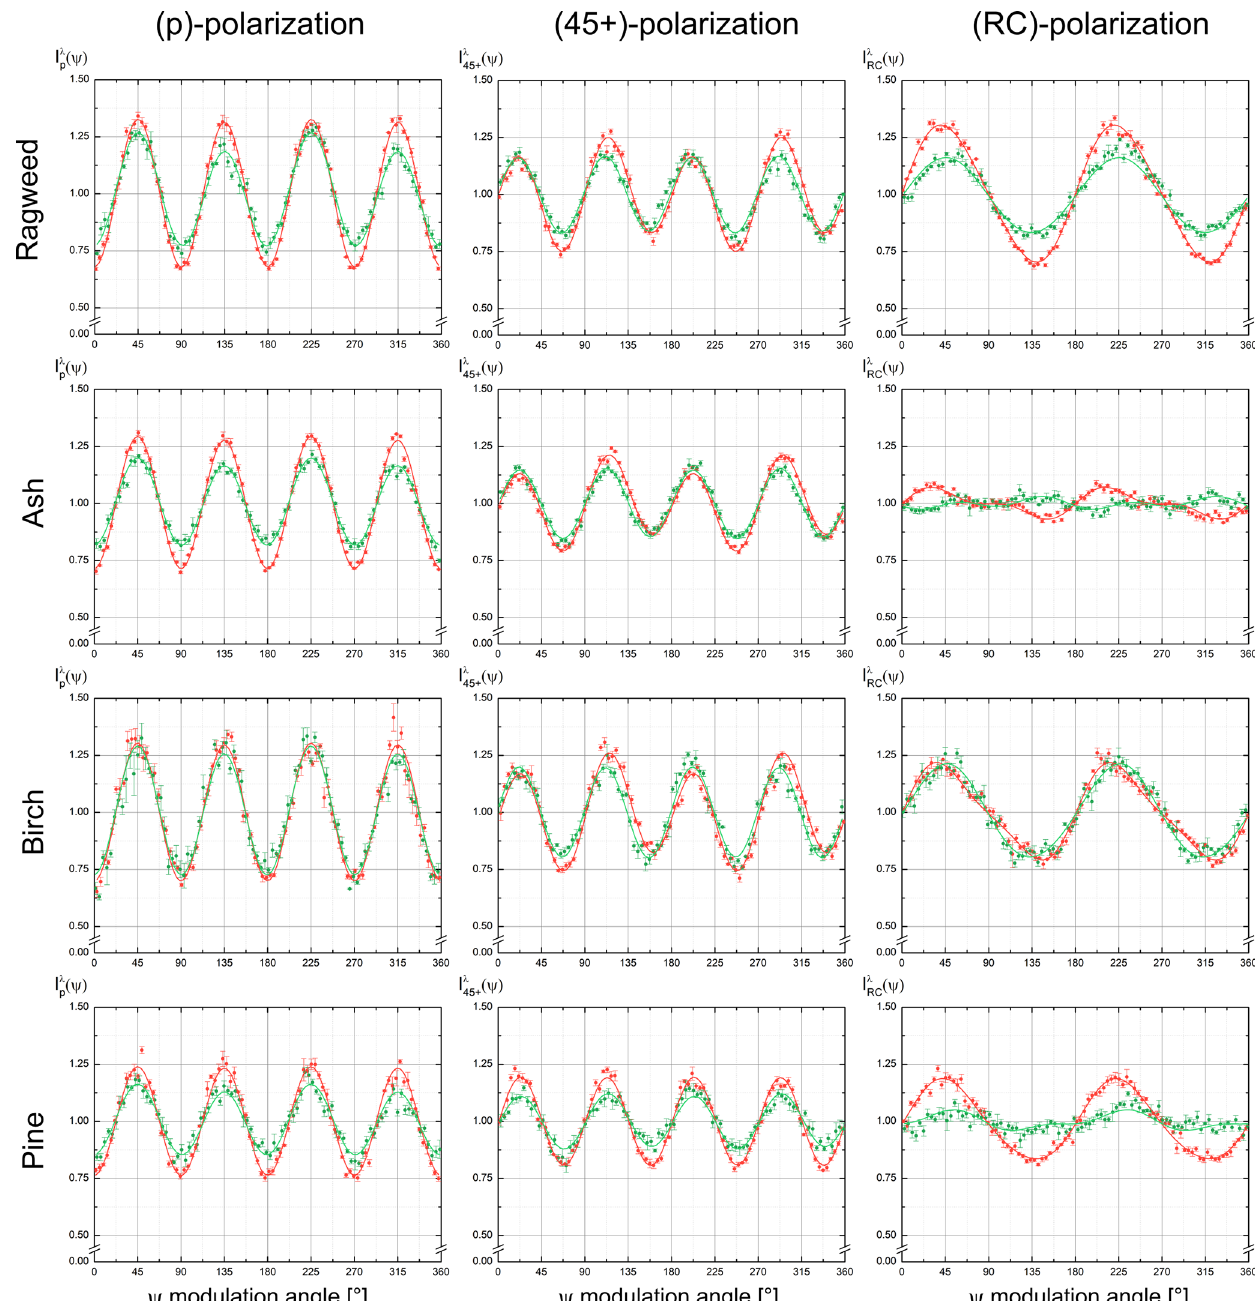
Figure 4. Detected scattered light intensity by ragweed, ash, birch and pine pollen as a function of the of the ψ angle of the analyser for the three successive incident polarization states ( p ), (45 + ) and (RC) at wavelength λ VIS (in green) and wavelength λ IR (in red). The detected = 1, as detailed in Sect. 3.3. A break has been inserted to ease the reading. Each measurement light intensity is normalized so that a i × I λ 0 data point is obtained by repeating 400 lasers shots, and the uncertainty is calculated by following the methodology described in Sect.